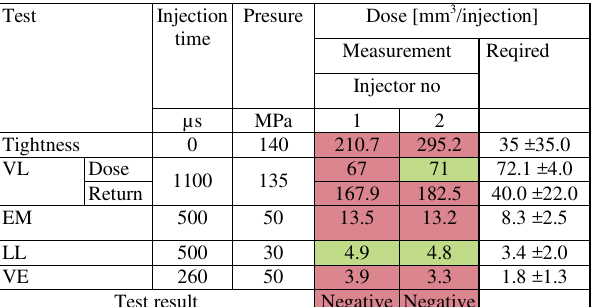
Table 5. Test results of injectors no 0 445 110